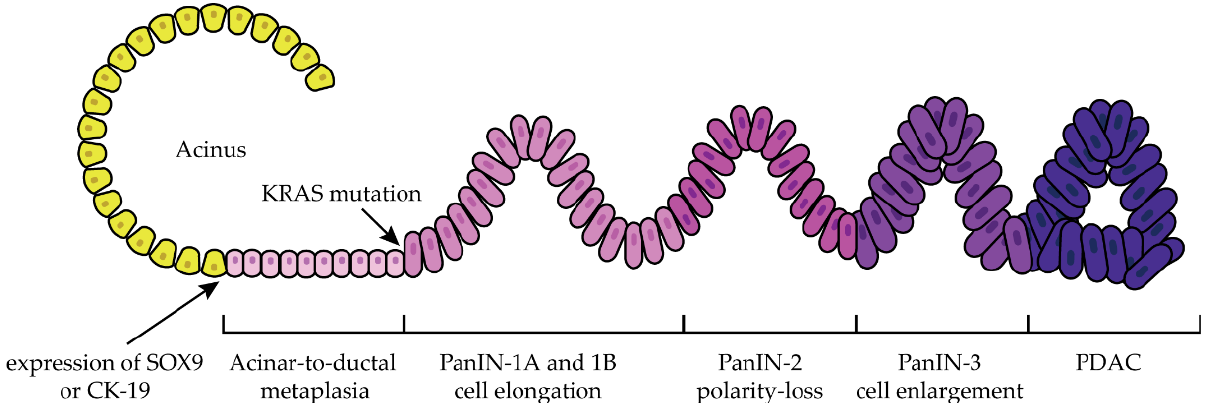
Figure 2. Progression of acinar cells to PDAC. The transition from normal to malignant cells started with ADM. The condition of ADM, as a consequence of KRAS mutation, evolves in pre-cancerous lesions called PanIN. From the initial stages of PanIN-1A and 1B where cells elongate, the malignancy progresses to the PanIN-2 stage characterized by moderate-grade cell lesions and cell polarity loss. Then, cells undergo enlargements, accumulating further genetic mutations until reaching the last stage with the PDAC setting [4].